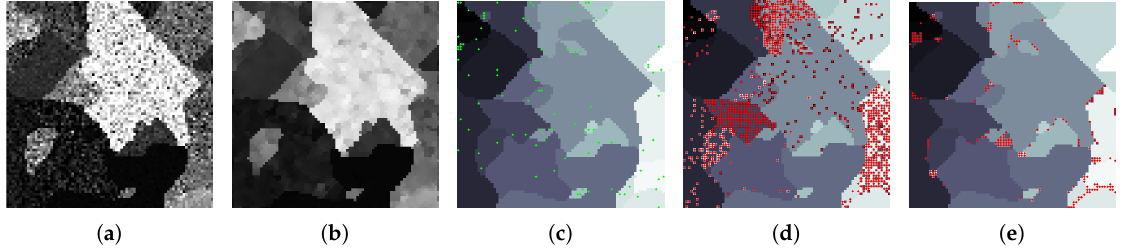
Figure 8. ( a ) 13th band of a very noisy synthetic 64-band image. ( b ) 13th band of the ECAS-II output, ( c ) Ground truth (green points represent training samples), ( d ) Classification produced by the SVM alone (red points represent misclassified pixels), ( e ) Classification produced by ECAS-II + SVM.